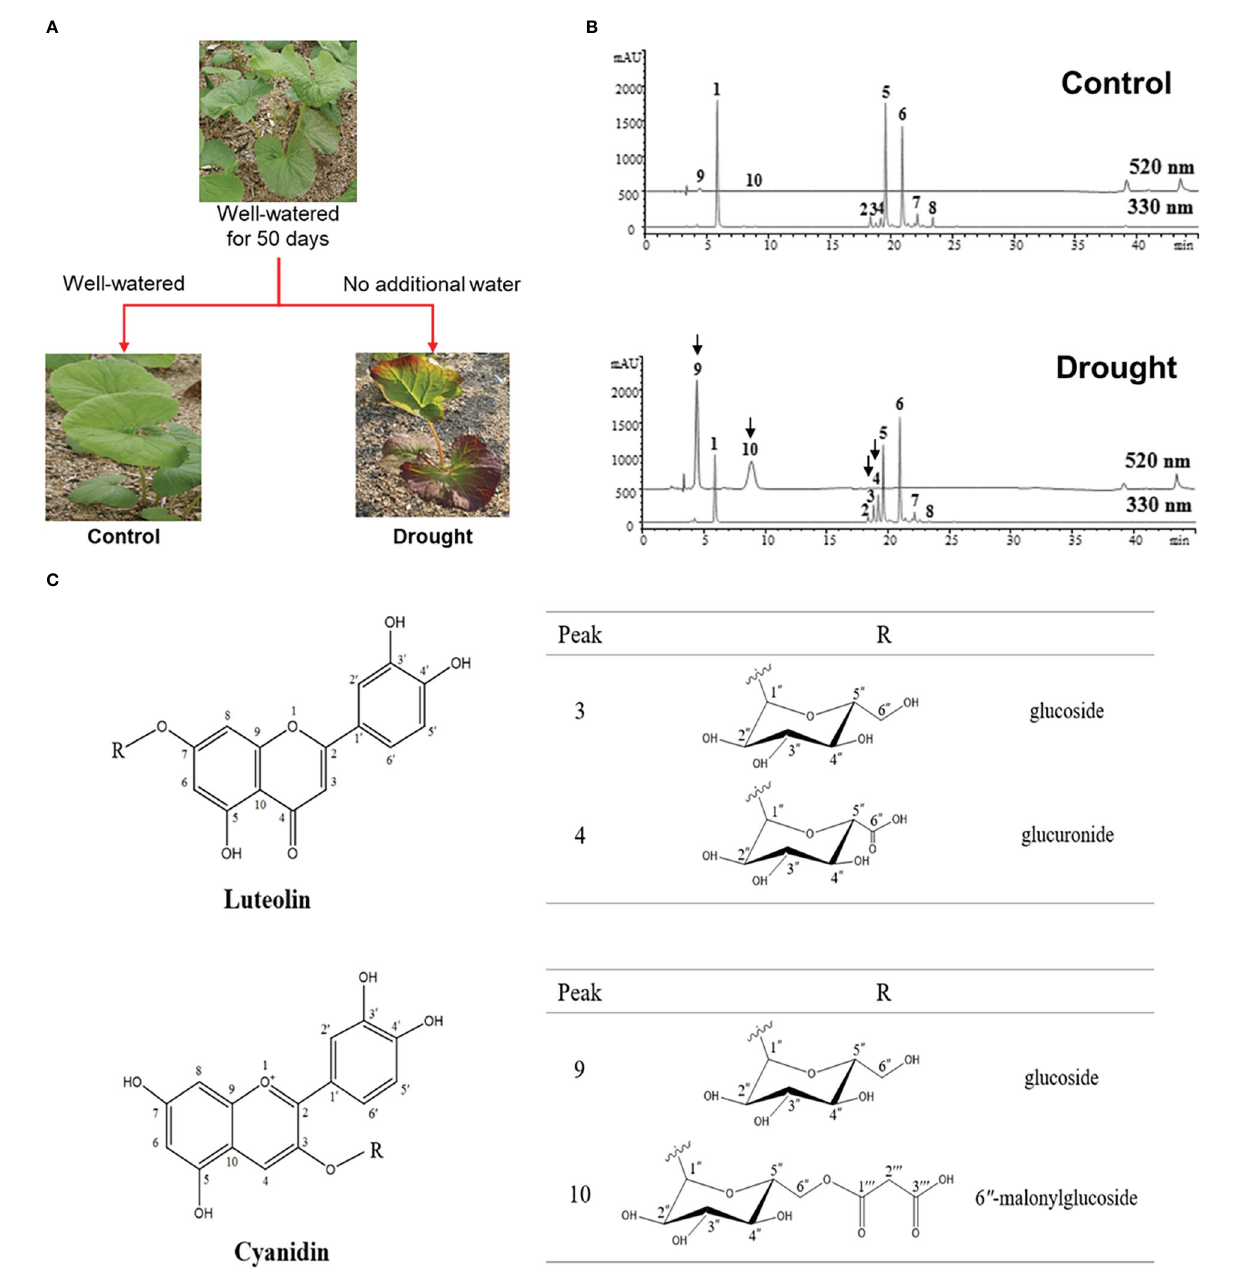
FIGURE 1 (A) Experimental scheme of phenotypes of L. fi scheri under drought stress (B) Representative HPLC chromatograms of leaf extracts from control and drought treatments, monitored at 330 nm and 520 nm. Peak 1, 5- O -Caffeolyquinic acid; 2, Hyperoside; 3, Luteolin-7- O - b -glucoside; 4, Luteolin-7- O - b - glucuronide; 5, 3,4-di- O -Caffeoylquinic acid; 6, 3,5-di- O -Caffeoylquinic acid; 7, 4,5-di- O -Caffeoylquinic acid; 8, 2 ″ -Acetylhyperoside; 9, Cyanidin-3- O - b -glucoside; and 10, Cyanidin-3- O - b -(6 ″ -malonylglucoside). (C) Chemical structures of fl avones and anthocyanins newly isolated from L. fi scheri